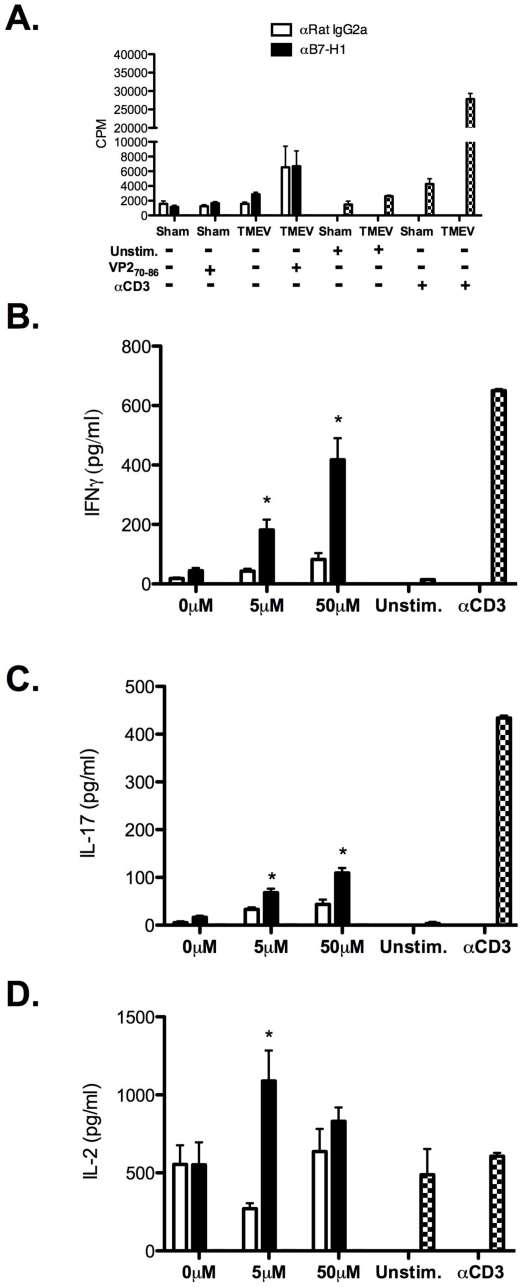
Blockade of B7-H1 enhances cytokine production from TMEV-specific CNS-infiltrating CD4+ T cells ex vivo.CNS (brain and spinal cord) mononuclear cells were isolated from TMEV-infected mice (n = 10/group) at day 7 post-infection and co-cultured in the presence of the CD4+ T cell restricted peptide-VP270–86. Control Ig (open bars) and anti-mouse B7-H1 (black bars) were added to the cultures. Unstimulated and anti-mouse CD3-stimulated CNS mononuclear cells served as negative and positive controls, respectively. A. Proliferation was analyzed by 3[H]-TdR uptake of triplicate wells per group. B–D. After 72 h, supernatants from triplicate wells of each group in (A), the levels of IFN-γ (B), IL-17 (C), and IL-2 (D) were measured using CBA technology. Data are representative of three separate experiments. *p<0.05 compared to cultures containing rat IgG2a control.